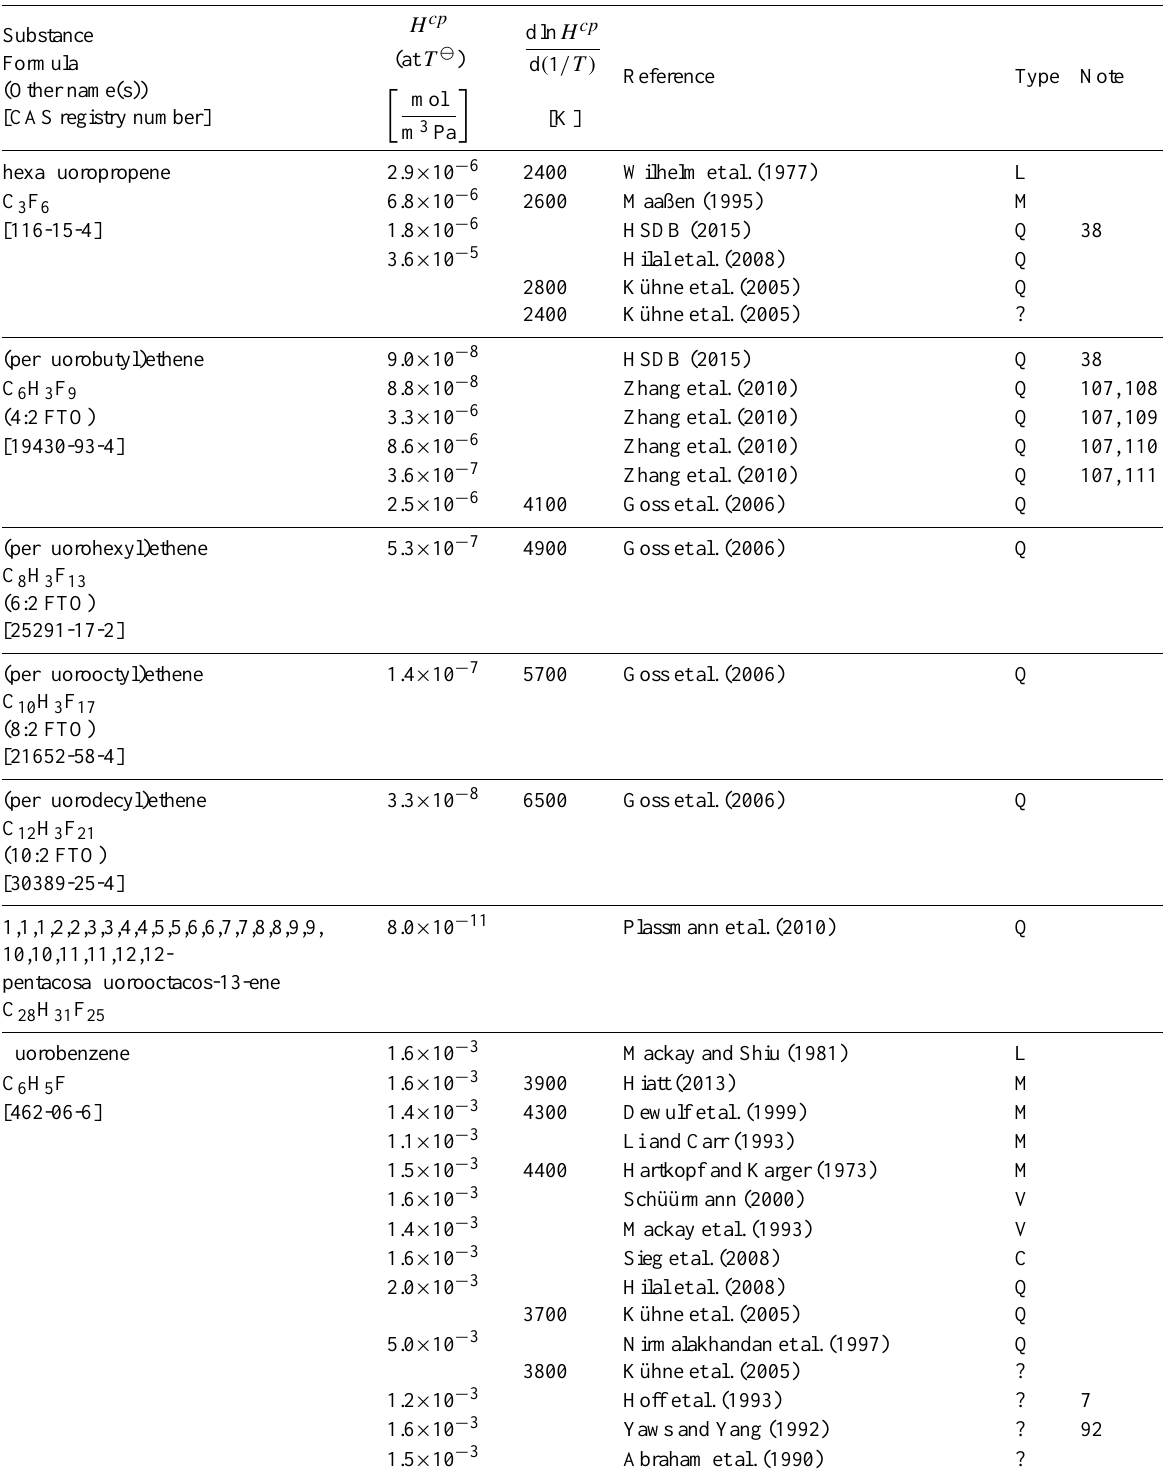
Table 6: Henry’s law constants for water as solvent